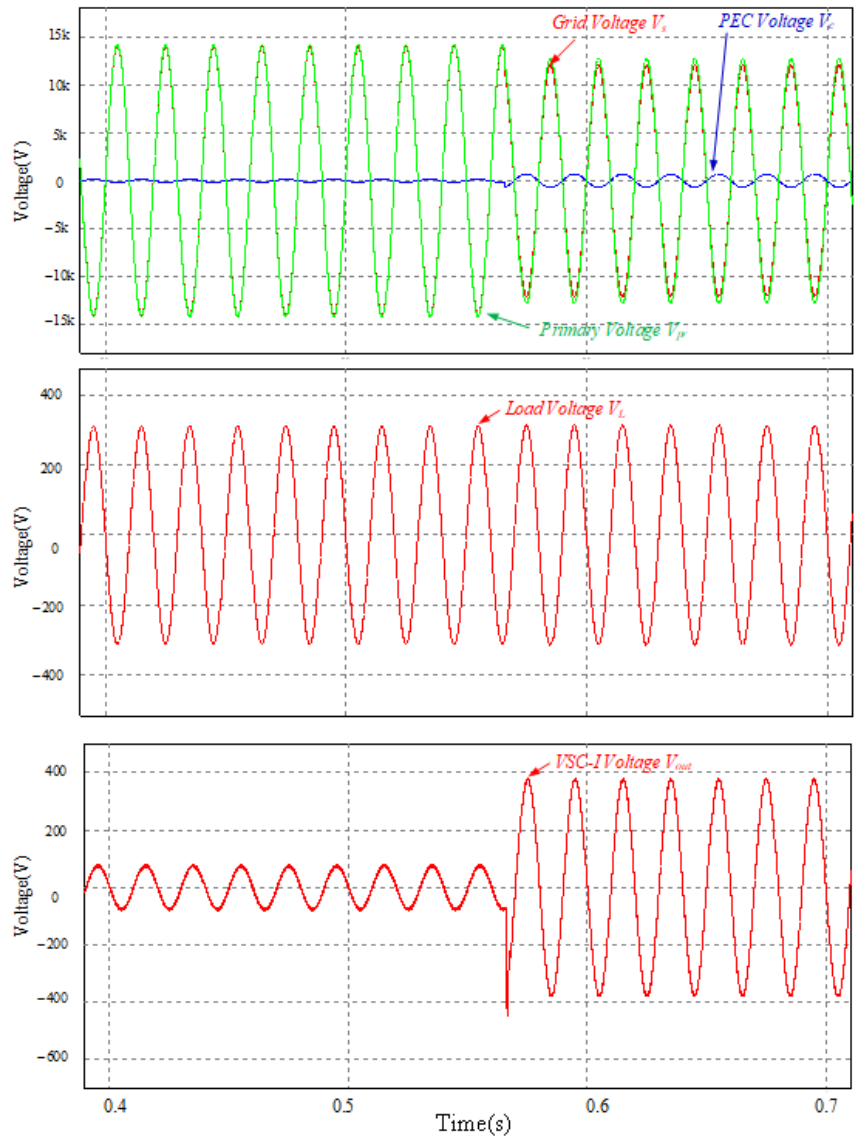
Figure 14. Voltage Waveforms during voltage regulation with Flexible OLVR.